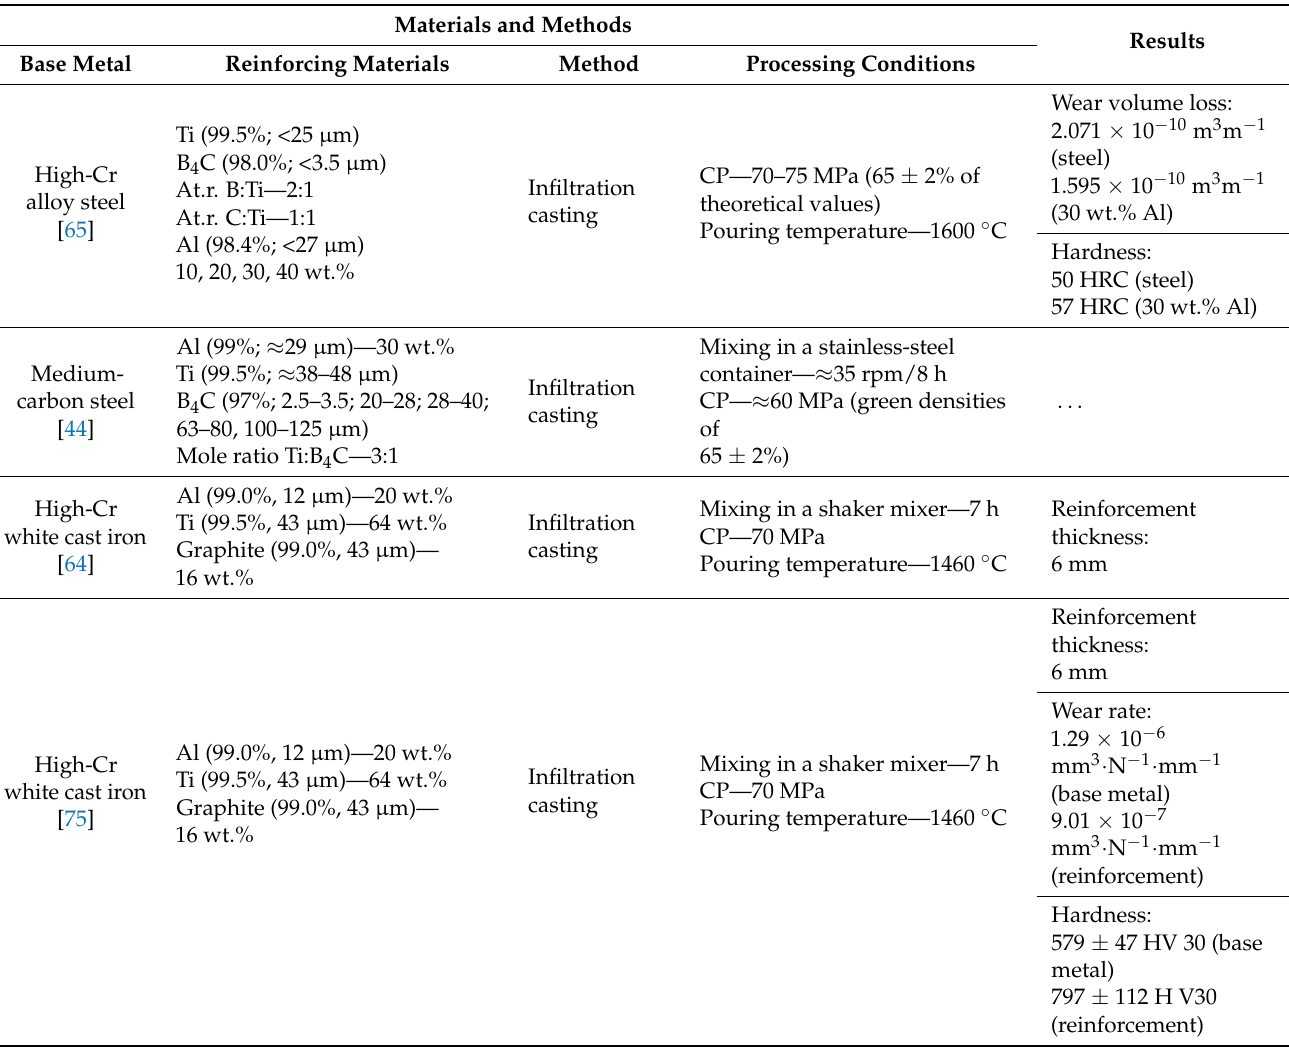
Table 7. Summary of experimental conditions and main results for SHS/casting processing using Al-Ti-C and Al-Ti-B 4 C powder